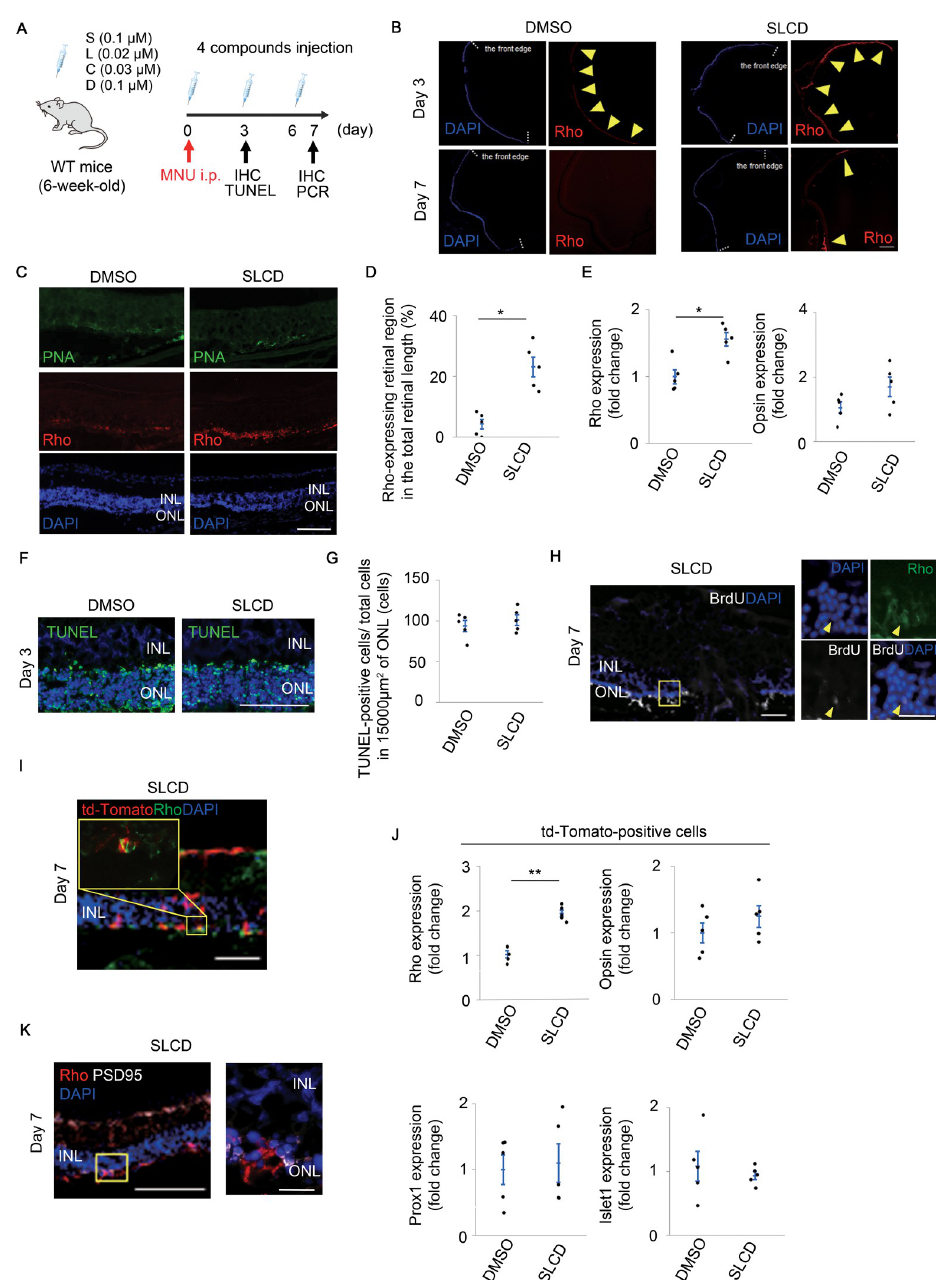
Fig 2. Differentiation of MCs into Rho-positive cells in MNU-treated mice via intravitreal injection of SLCD. A) Time course of the in vivo experiments using MNU-treated mice. After a single systemic administration of 75 mg/kg MNU, intravitreal injection of SLCD was performed every 3 days. i.p., intraperitoneal injection; TUNEL, TdT- mediated dUTP nick end labeling. B) Immunohistochemistry results of Rho (arrowheads) and DAPI on days 3 and 7 after the intravitreal injection of SLCD into MNU-treated mice. White dotted lines indicate the anterior edge of the retina. Scale bar = 400 μ m. C) Magnified images of Rho (red) and PNA (green) expression in (B) (n = 5). Scale bar = 100 μ m. D) Quantitative results of the Rho-expressing retinal region in the total retinal length (B) (n = 5). E) Real-time qPCR results of the opsin and Rho expression in the whole retina on day 7 after the intravitreal injection of SLCD (n = 5). F) and G) TUNEL staining (F) and quantification of the TUNEL-positive photoreceptor cells (G) on day 3 after the intravitreal injection of SLCD (n = 5). Scale bar = 100 μ m. H) The Rho-positive cells in the ONL (yellow arrowhead) also expressed BrdU on day 7 after the intravitreal injection of SLCD. Scale bar = 50 μ m. Magnified images of yellow-framed are shown on the right (n = 5). Scale bar = 20 μ m. I) Td-Tomato (red) was co-expressed with Rho (green) in the outer retinal layer on day 7 after intravitreal injection of SLCD into MNU-treated GFAP-td-Tomato